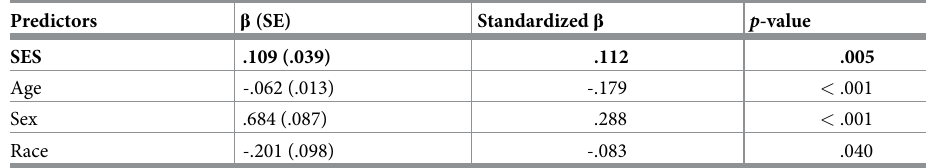
Table 2. Multivariable linear regression Model 1: SES and brain